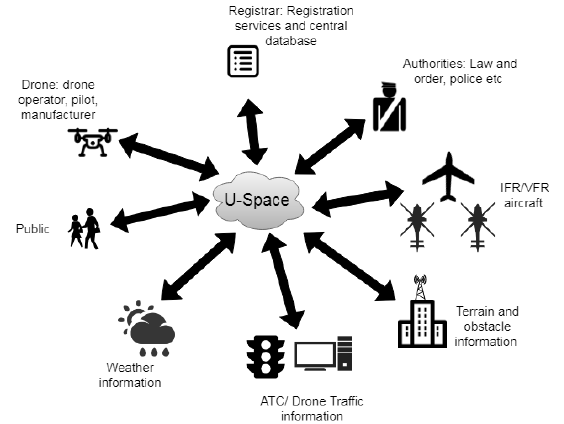
Figure 4. Visual representation of